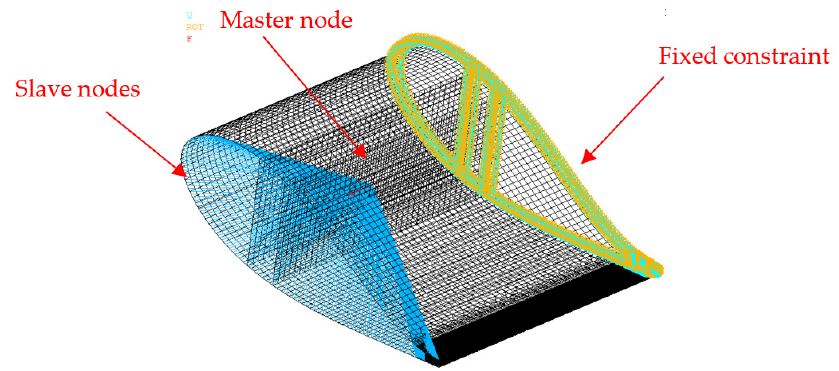
Figure 9. Schematic of blade segment.